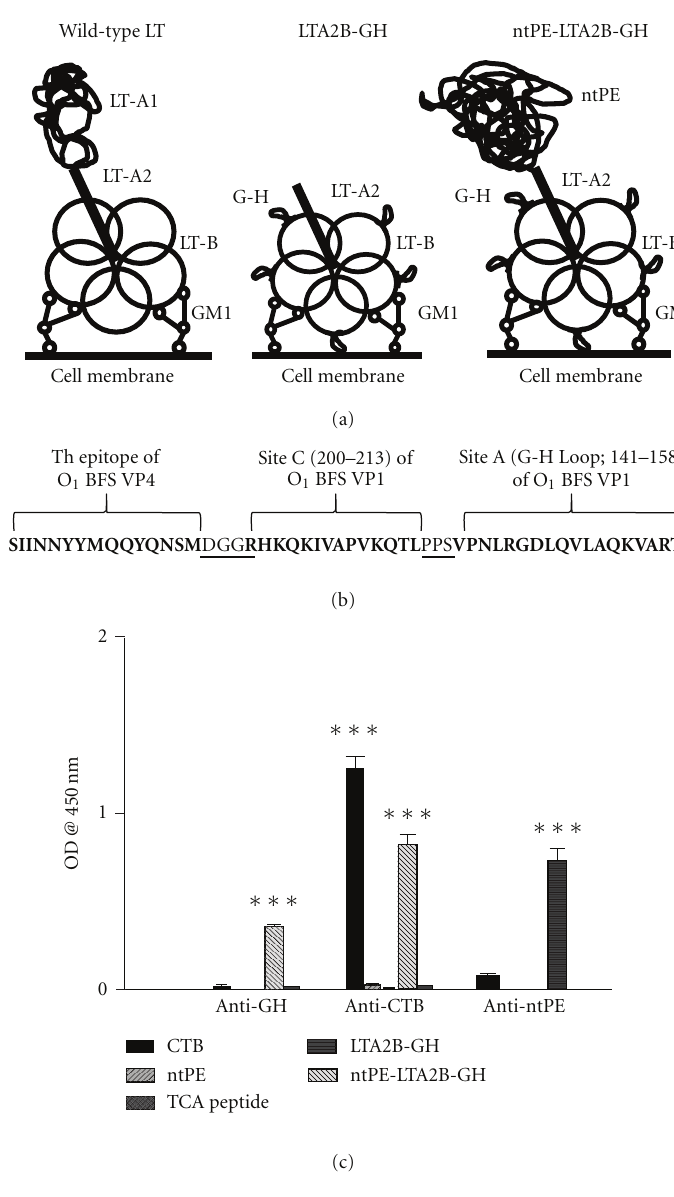
Figure 2: (a) Predicted structure of vaccine constructs. Wild-type LT binds to GM1 receptors upon pentamerization of LT-B and translocates the toxic LT-A subunit into host cells. LTA2B-GH is predicted to pentamerize in a similar fashion to the wild-type toxin, thereby, presenting five copies of the G-H loop to the host. ntPE-LTA2B-GH additionally contains ntPE in place of LT-A1 in order to expand receptor repertoire of the vaccine. (b) Amino acid sequence of the “TCA” peptide. The N-terminus consists of a promiscuous T-helper cells epitope from VP4 of FMDV (bold), followed by linking amino acids GG (underlined), “site C” from VP1 (bold), another linker sequence (PPS, underlined), and site A (the G-H loop). (c) GM1 ELISA to illustrate the pentamerization of LTA2B-GH and ntPE-LTA2B-GH. Microtiter plates were coated with GM1 and incubated with CTB, TCA peptide, ntPE, LTA2B-GH, and ntPE-LTA2B-GH. Then they were tested with anti-G-H, anti-CTB and anti-ntPE antibodies to illustrate the GM1-binding capacity of fusion proteins. ∗∗∗ P value < 0.001 according to ANOVA and post-hoc Tukey-Kramer multiple comparison